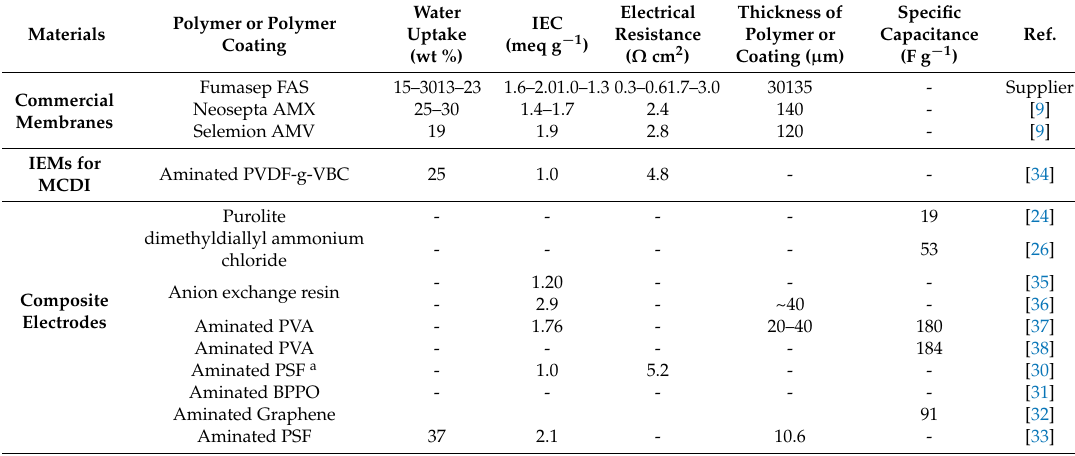
Table 2. Fabrication and characterization properties of different anion-exchange membranes (AEMs) and composite electrodes for MCDI process.